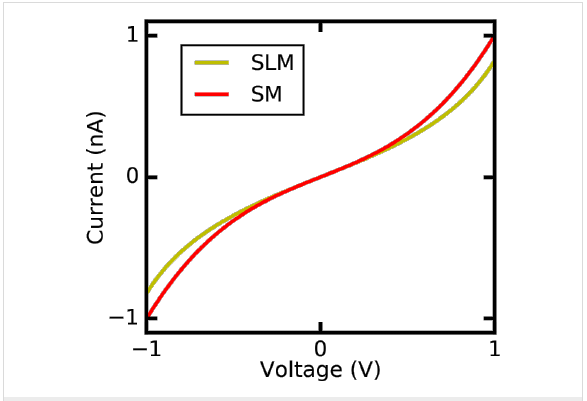
Figure 1: Comparison of Simmons model (SM) and single-level model (SLM) for the parameters Φ = 0.8 eV, d = 1.06 nm, A = 0.3 nm 2 , and E 0 = 0.8 eV, Γ = 0.001 eV. The linear conductance in both cases corre- sponds to 6.25·10 − 6 G 0